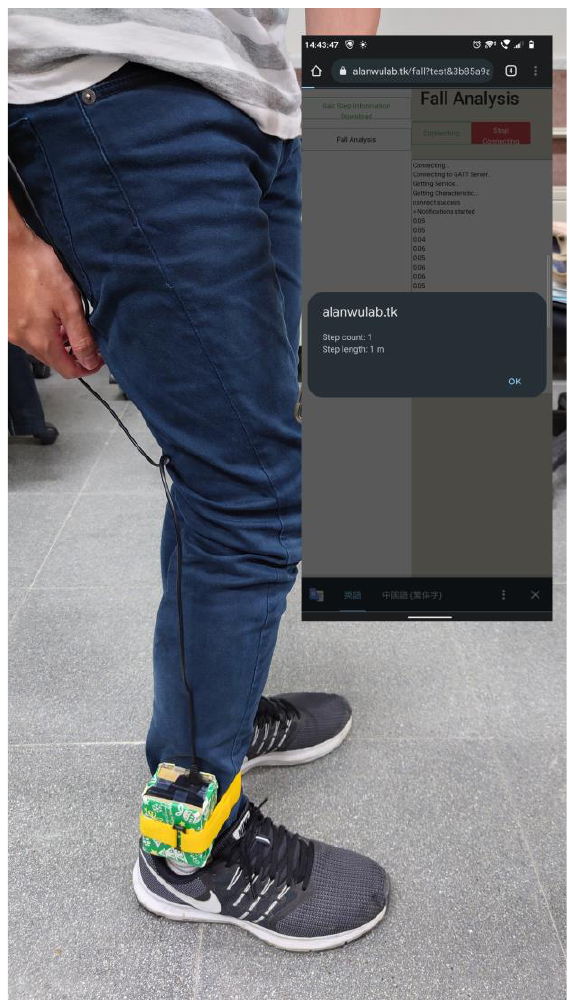
Figure 6. Step count detection of CPGAFDWD in Android.